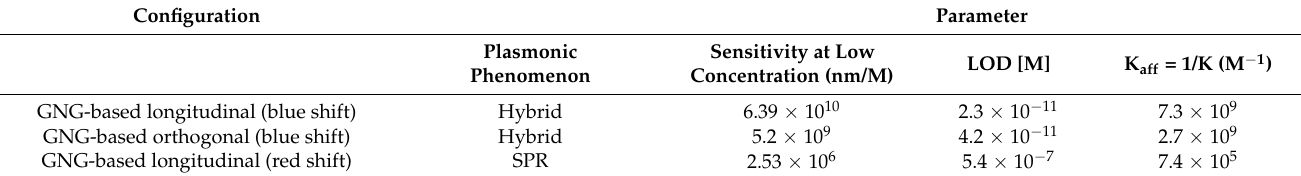
Table 2. Chemical parameters relative to the BSA detection for the tested sensor configurations.